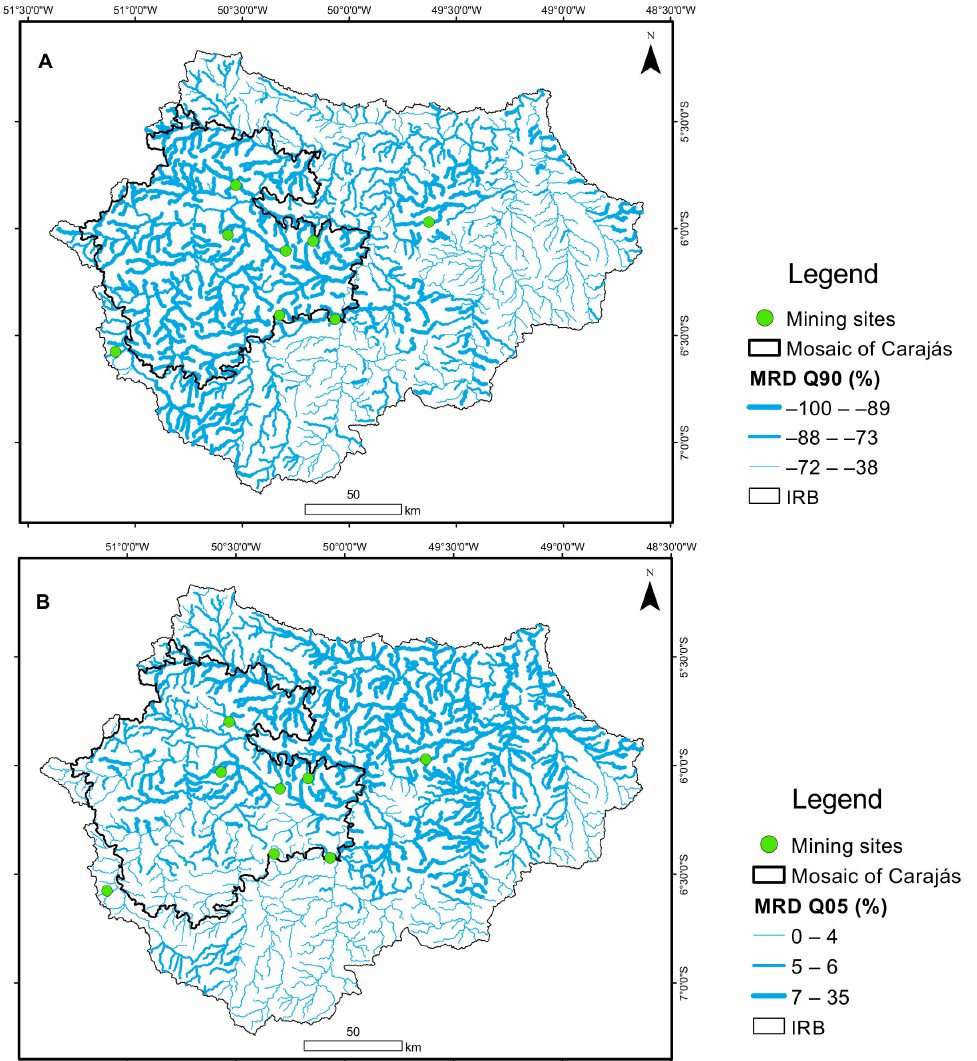
Figure 14. Mean relative differences in Q90 ( A ) and Q5 ( B ) between the future (RCP8.5) and reference periods and both scenarios spatialized in the IRB (we decided not to show the results of RCP4.5 because the results showed similar spatial